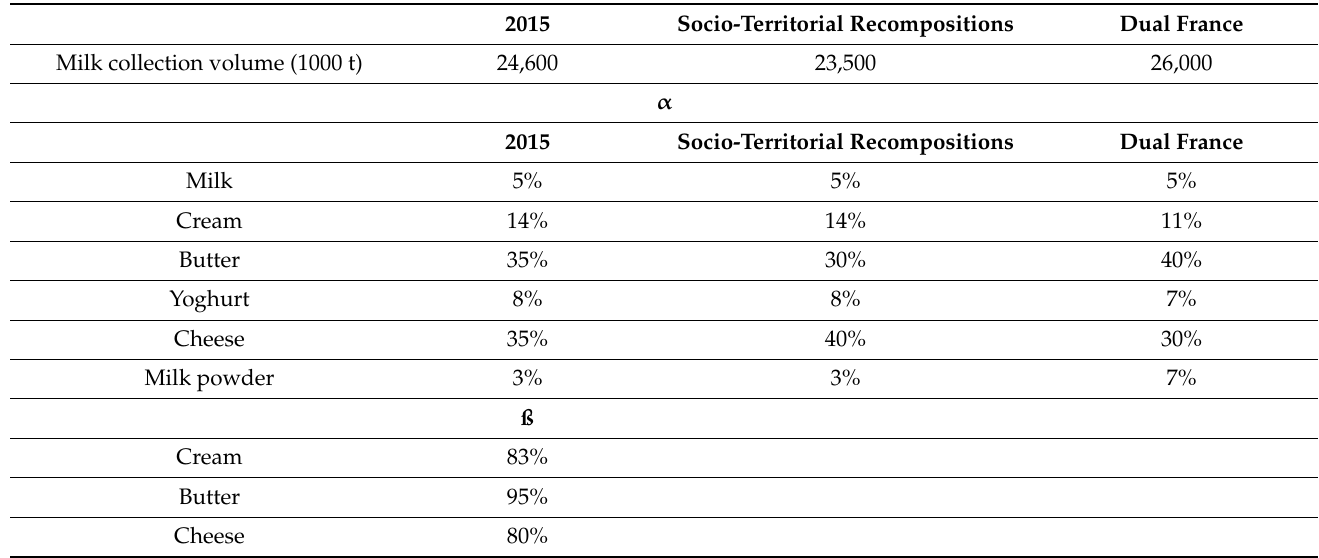
Table 2. Hypothesis for 2015 and the 2030 scenarios regarding the volume of milk collected, α and ß